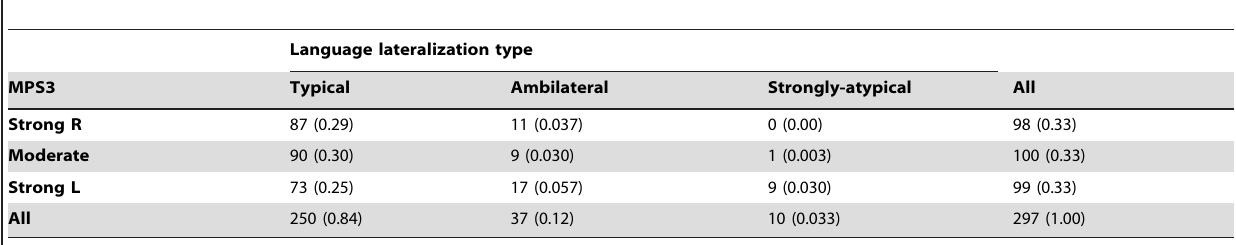
Table 8. Contingency table of language hemispheric lateralization type by manual preference